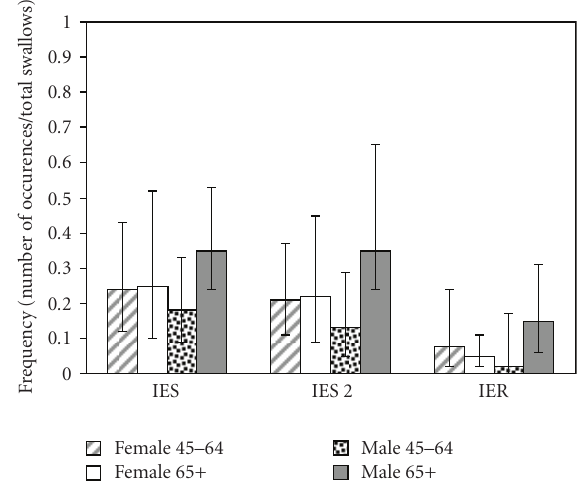
∗ Error bars represent 95% confidence intervals Figure 4: Frequency of IES, IES Grade 2 (IES 2) and IER in swallows of males and females ages 45–64 and 65 and